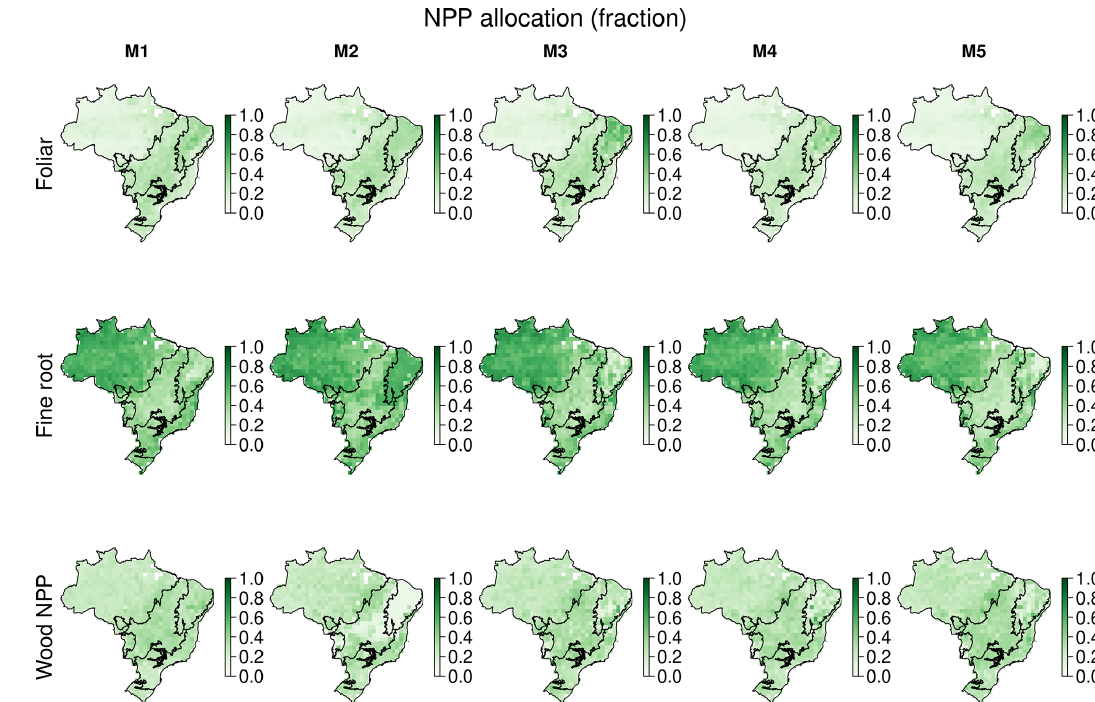
Figure A12. Maps of the localised median estimates of NPP allocation fractions to live tissue for each model.